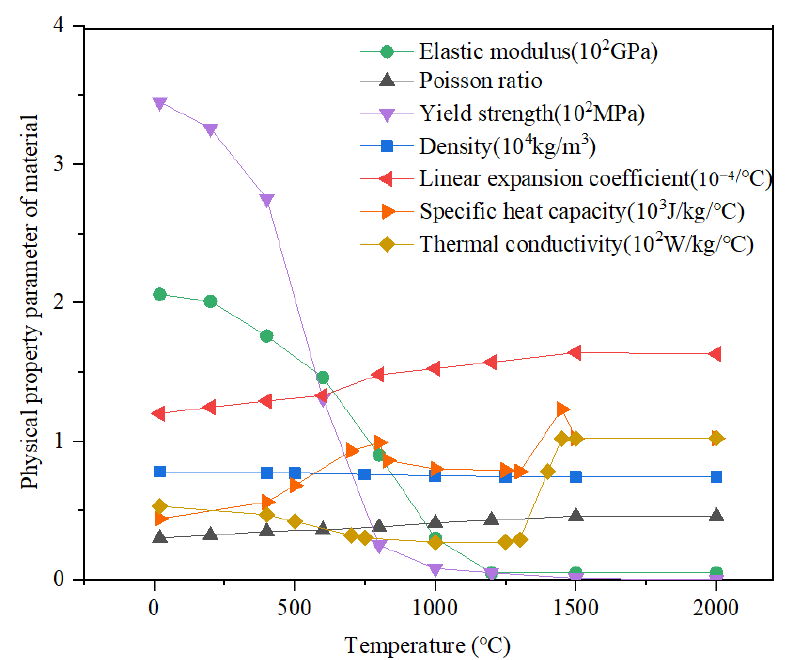
Figure 3. The thermophysical material parameters of Q345 steel